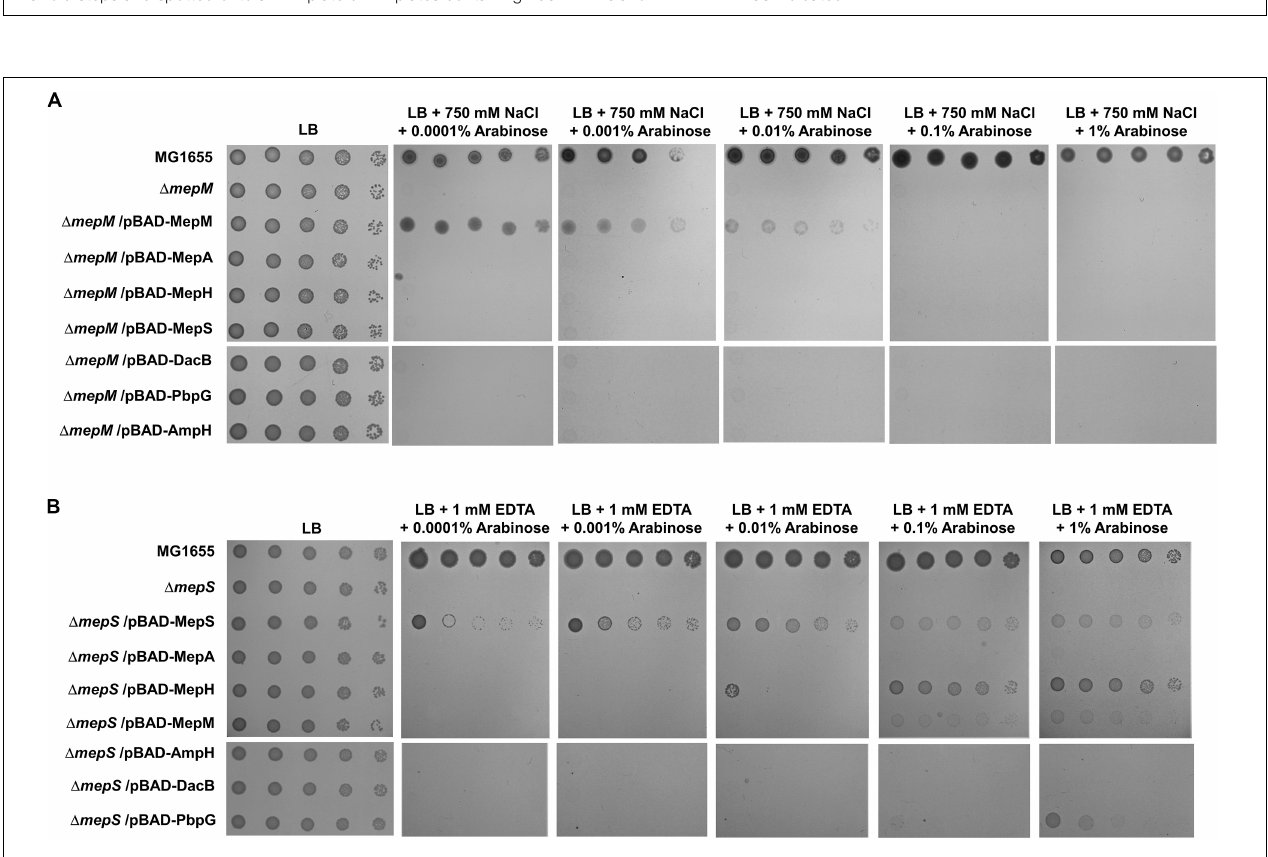
FIGURE 2 | Complementation analysis of the phenotypes of the mepM and mepS mutants. (A) The wild-type, mepM mutant, and mepM mutant cells harboring the indicated plasmids were serially diluted from 10 8 to 10 4 cells/mL in 10-fold steps and spotted onto an LB plate or LB plates containing 750 mM NaCl and the indicated concentrations of arabinose. (B) The wild-type, mepS mutant, and mepS mutant cells harboring the indicated plasmids were serially diluted from 10 8 to 10 4 cells/mL in 10-fold steps and spotted onto an LB plate or LB plates containing 1 mM EDTA and the indicated concentrations of arabinose.